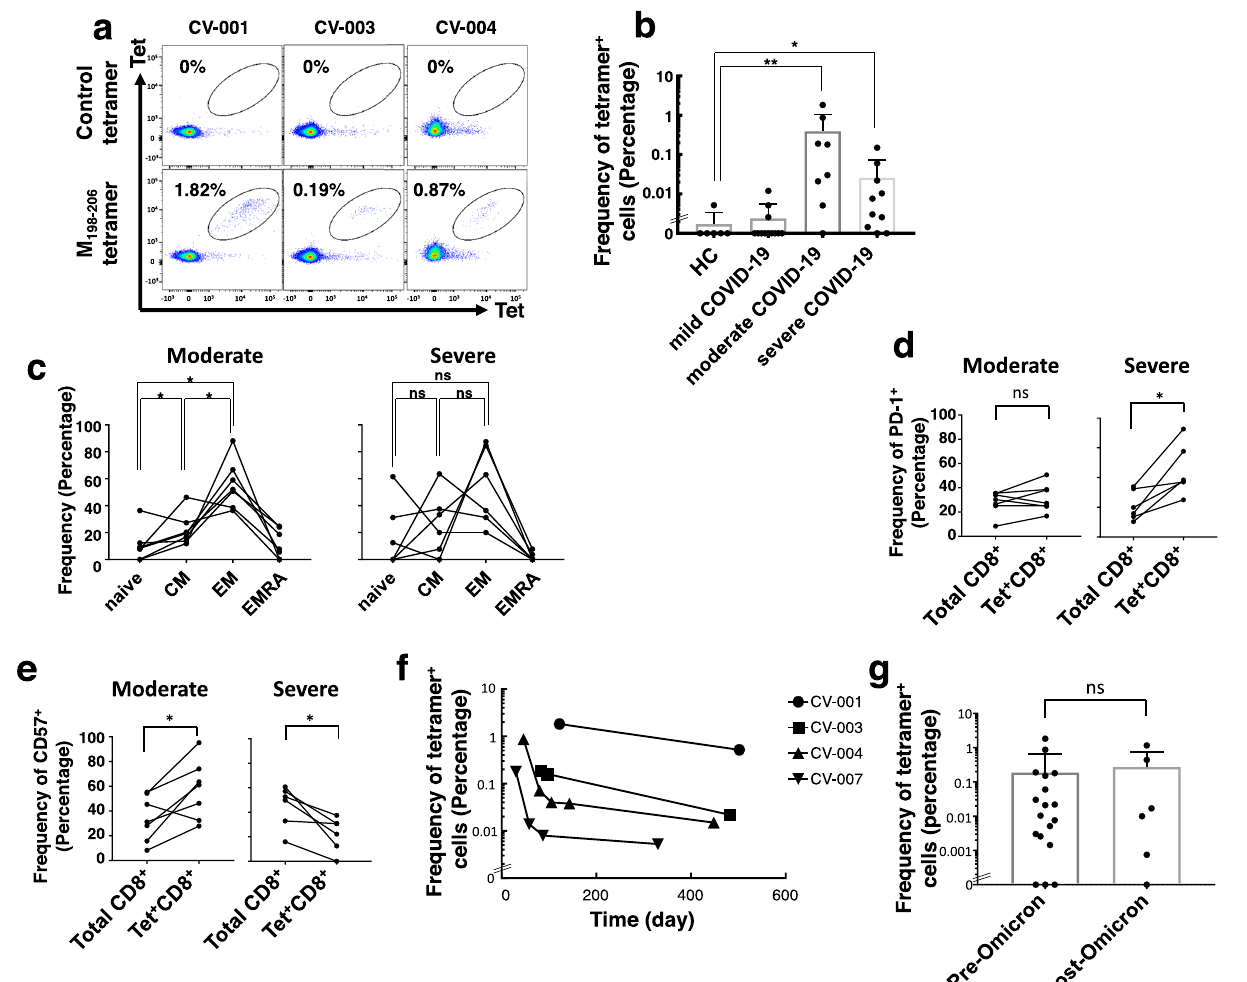
Fig. 4 | Phenotypic analysis of M198 – 206-speci fi c CD8+ T cells in PBMC. Flow cytometric analysis of M 198 – 206 -speci fi c CD8 + T cells. a Representative data of M 198 – 206 tetramerstainingofPBMCfrommoderateCOVID-19convalescents. b The frequencies of tetramer-positive cells were compared among indicated groups (healthy donors (HC), n =6; mild, n =12; moderate, n =8; severe, n =10). Data represent mean+SD. p values were calculated by a two-sided Mann – Whitney test. ** p =0.0073, * p =0.024. c Subsets of M 198 – 206 -speci fi c CD8 + T cells from COVID-19 convalescents ( n =13; 7 moderate and 6 severe subjects) were analyzed based on CD45RA and CCR7 staining. p values were calculated by two-sided Wilcoxon matched-pairs signed rank test. * p =0.047 (naive-CM), 0.031 (CM-EM), and 0.031 (naive-EM) for moderate; * p =0.69 (naive-CM), 0.31 (CM-EM), and 0.19 (naive-EM)